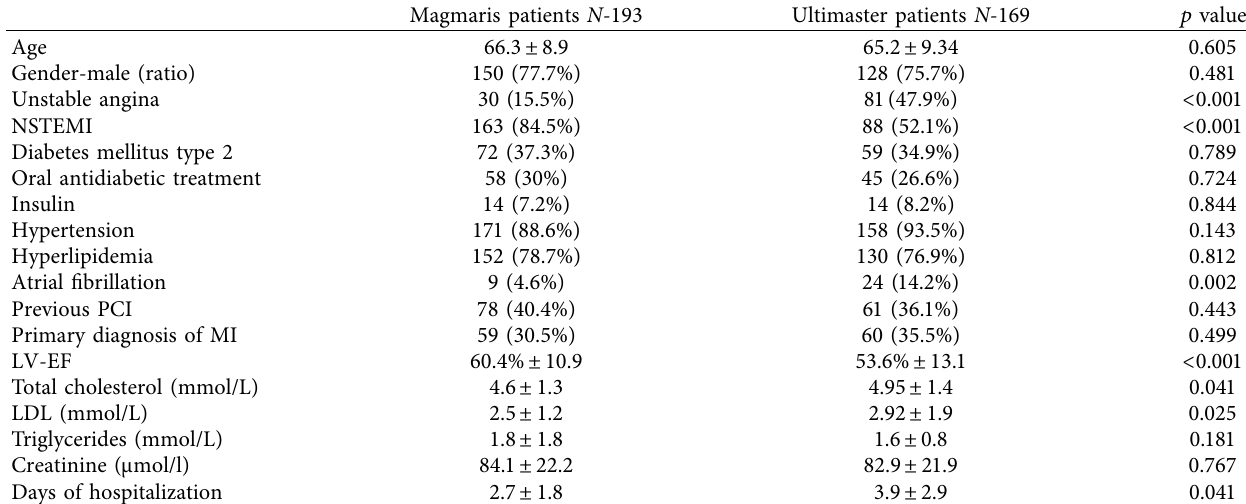
Table 1: Study patient